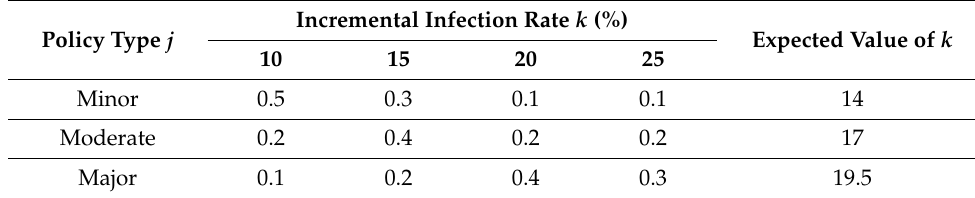
Table 6. Scenario 1: probabilities of incremental infection rates by policy